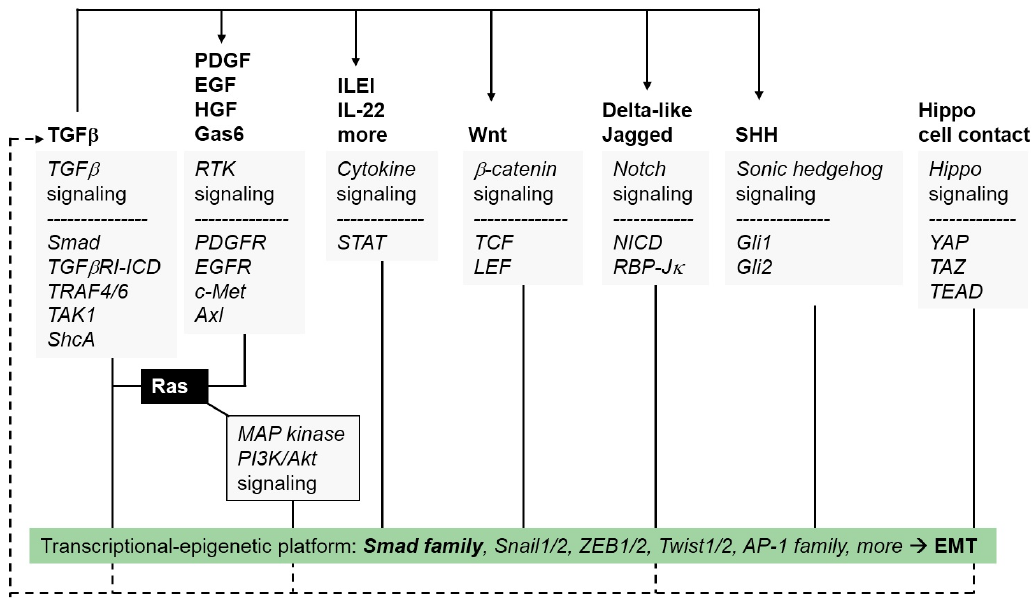
Figure 3. Crosstalk between TGF β and other signaling pathways during EMT. TGF β signaling is listed together with six additional signaling pathways. Each pathway is summarized above the dotted line. Secreted growth factors that initiate the pathways are listed in bold on the top. Signaling mediators are listed below the dotted line in the grey boxes. All pathways interact with each other in regulating the expression and/or activity of transcription factors that elicit the EMT. Examples of such transcriptional regulators are shown. The Ras small GTPase is highlighted due to its central role in the process of tumorigenesis and EMT. The downstream kinase pathways initiated by Ras are shown separately. TGF β is known to induce expression of ligands for many other pathways (top arrows). Upon activation of transcription, many pathways induce the expression of TGF β family ligands (bottom straight and dotted arrows).